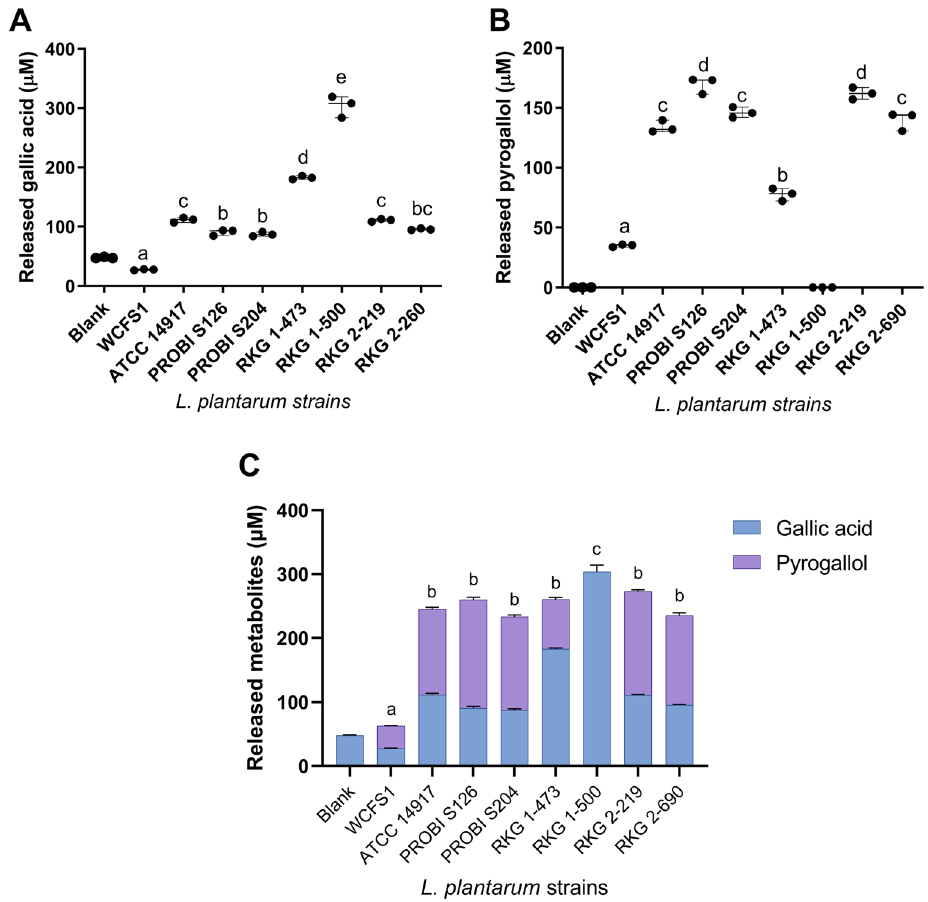
Figure 4. Phenolic metabolite-release by the selected TanA + L. plantarum strains cultured in a tannic acid- rich medium. ( a ) Released gallic acid; ( b ) released pyrogallol; ( c ) total released metabolites. The values of three independent experiments or their mean ± SEM are shown. Different letters show statistical differences between strains at < p 0.01. Ordinary One-way ANOVA with Tukey’s post hoc test was used to compare strains. Strains that produced no detectable metabolites were removed from comparations. The blank (uninoculated media) contained a residual gallic acid from the tannic acid reagent that increased over time due to degradation at incubation conditions (30